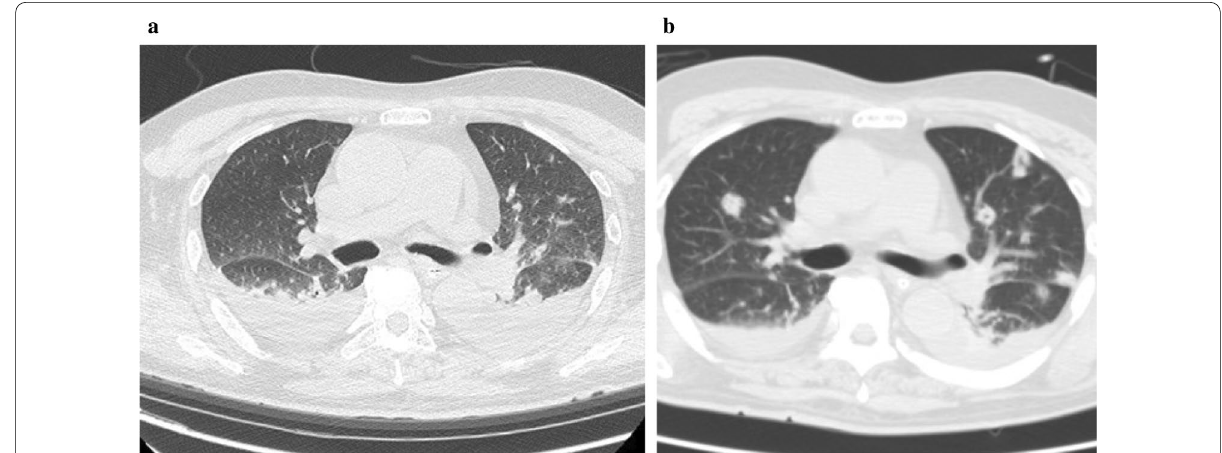
Fig. 1 a Computed tomography scan performed 9 days before living-donor liver transplantation. Only a small amount of pleural effusion was present. b Computed tomography scan performed 3 days before living-donor liver transplantation. Some small nodular shadows were